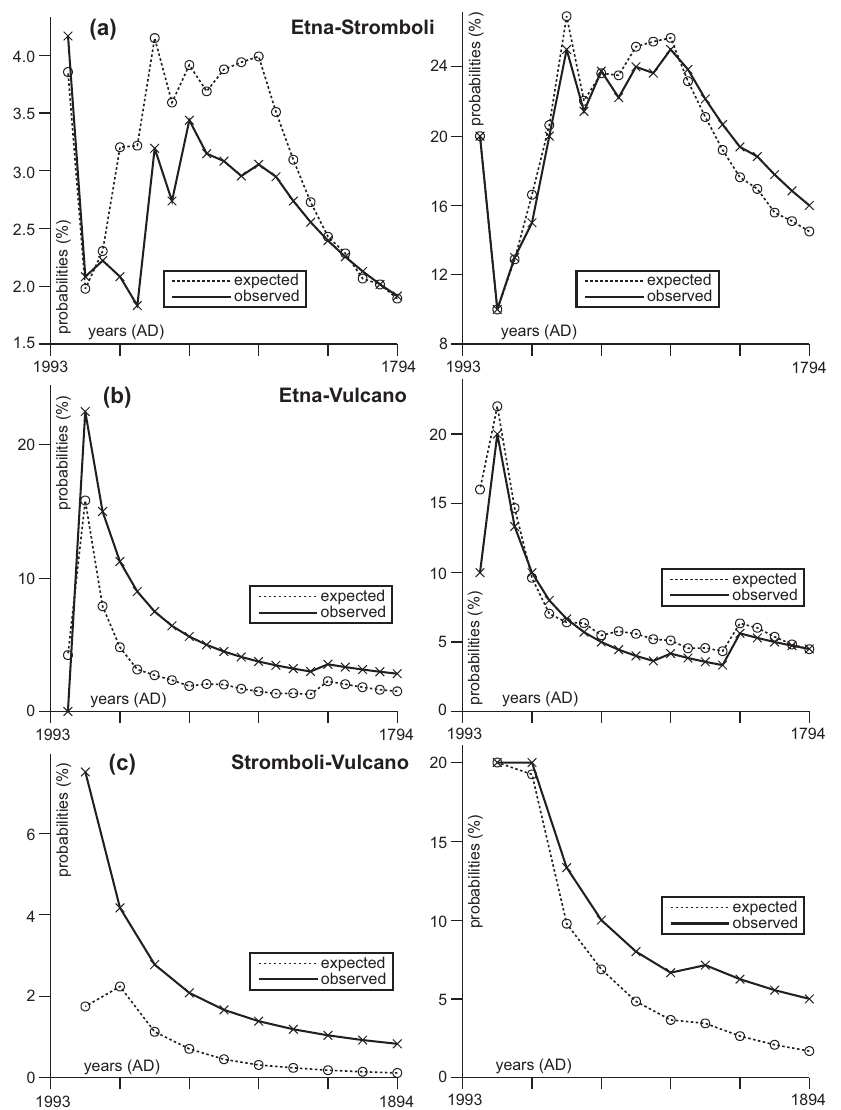
Fig. 4a-c. Expected and observed probabilities of occurrence of months (diagrams to the left) and years (dia- grams to the right) including concurrent eruptions at (a) Etna and Stromboli, (b) Etna and Vulcano, and (c) Stromboli and Vulcano, versus time. Data (tables III and IV) are from Simkin and Siebert (1994). A rather high correlation of activity is observed in (b) and